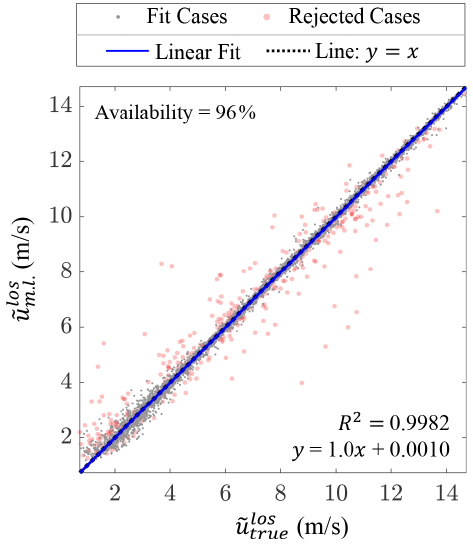
Figure 7. Relationship between machine-learning-predicted spectral median, ˜ u los , and the true value, ˜ u los true , from the 13383 ml testing cases. The red data indicate predictions with low confidence as explained in Sect. 3.3.3. Removing these data points, which was done before the regression fitting, leaves partial data availability as indicated. Note that the y = x line is mostly obstructed from view by the linear fit